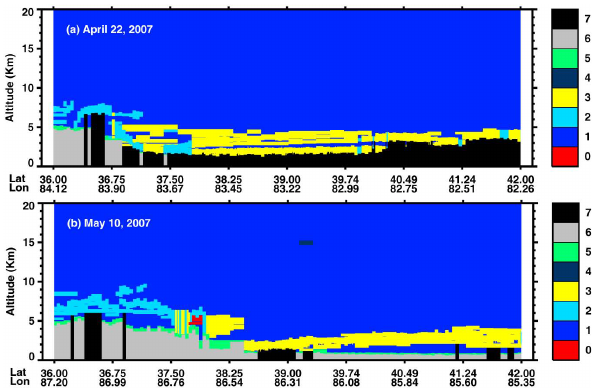
Fig. 6 CLIM method feature mask for the first case, (a) 22 April 2007, and the second case, (b) 10 May 2007,